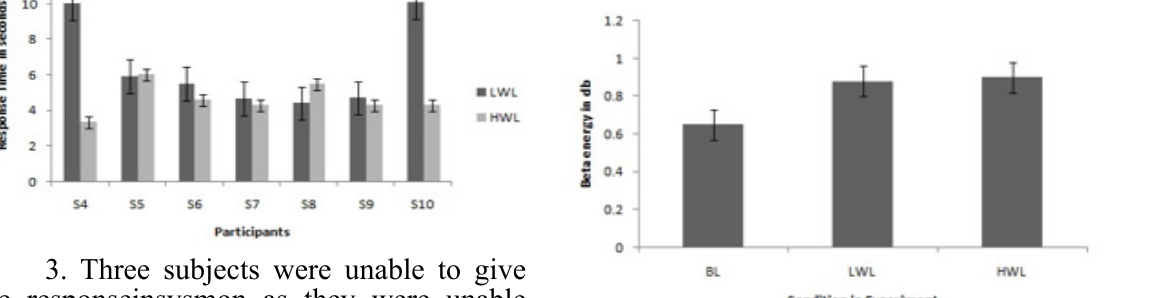
Figure 6. Beta energy for AF3 channel for dif - ferent condition, energy is summarized among all ten participants. BL=baseline, LWL=Low Workload, HWL=High Workload